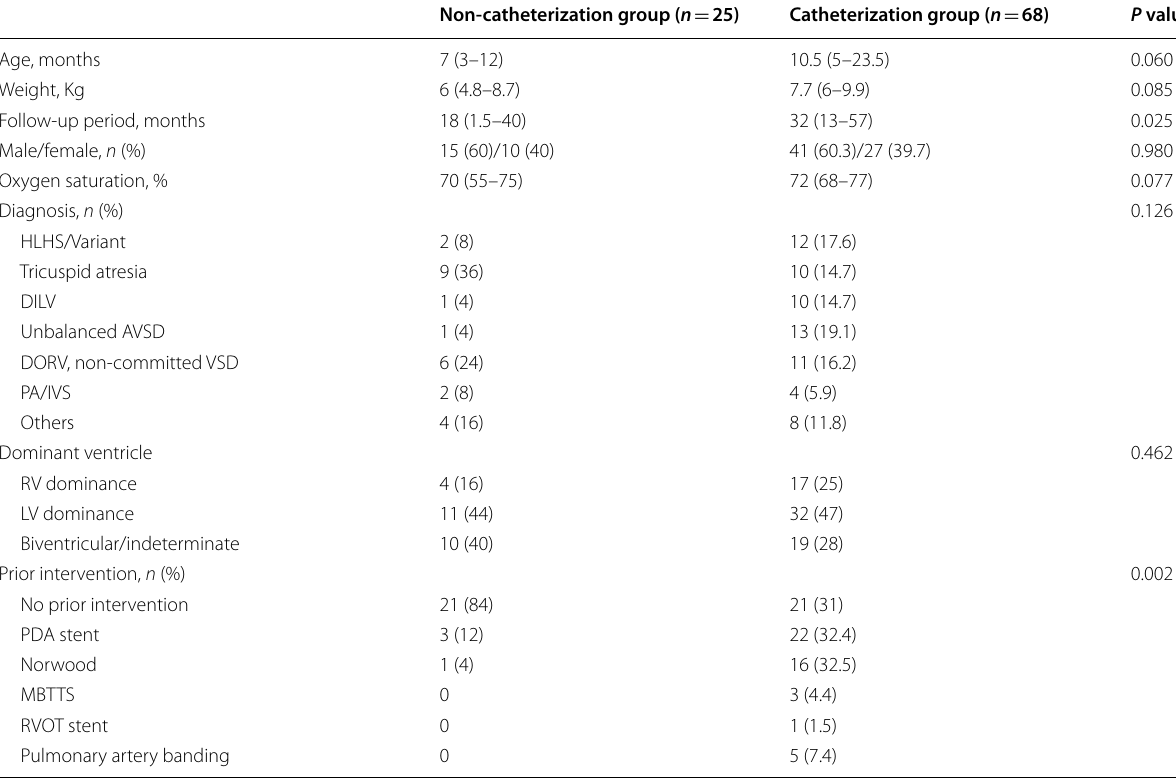
Table 1 Clinical characteristics of patients’